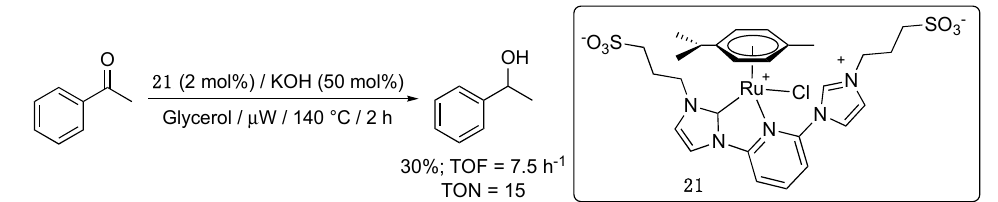
Scheme 13. TH of acetophenone from glycerol catalyzed by the bis-sulfonated complex 21